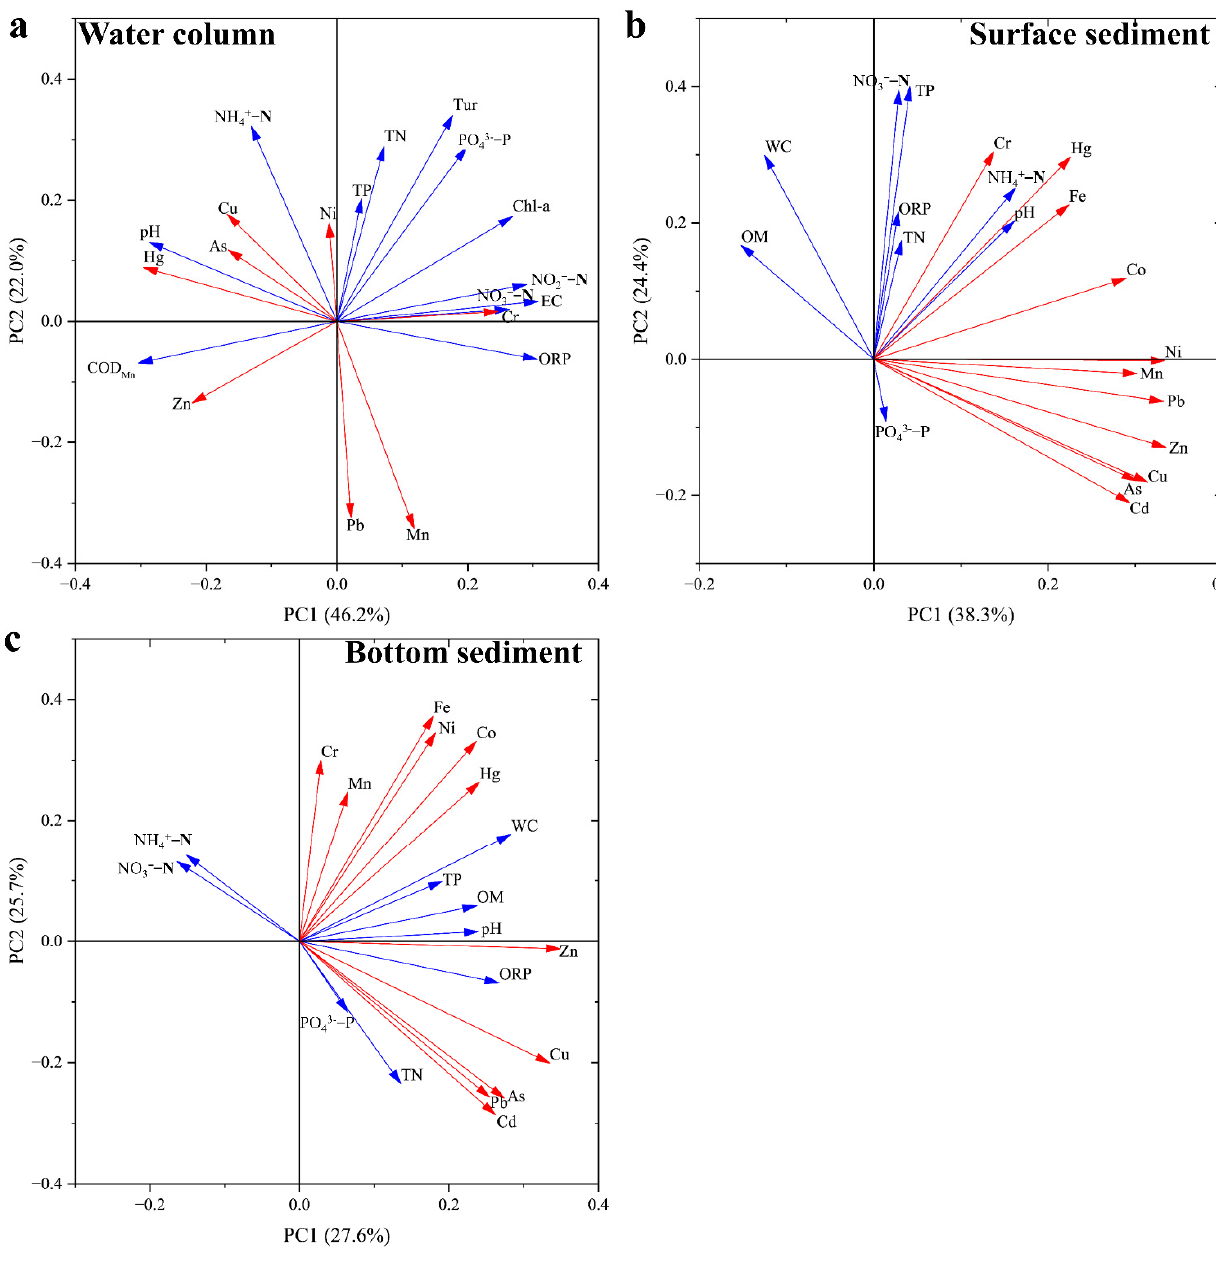
Figure 6. PCA of heavy metals and physiochemical parameters in the water column ( a ), surface sediment ( b ), and bottom sediment ( c ).